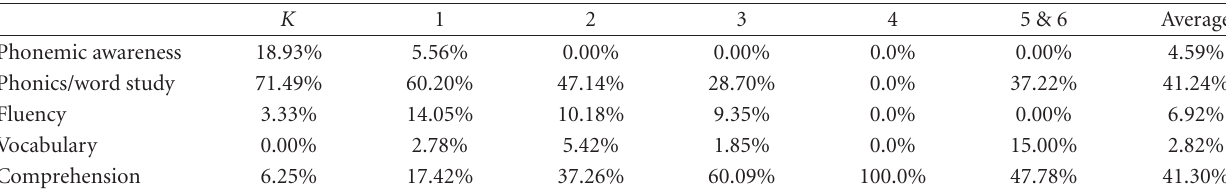
Table 1: Frequency of observed reading components.